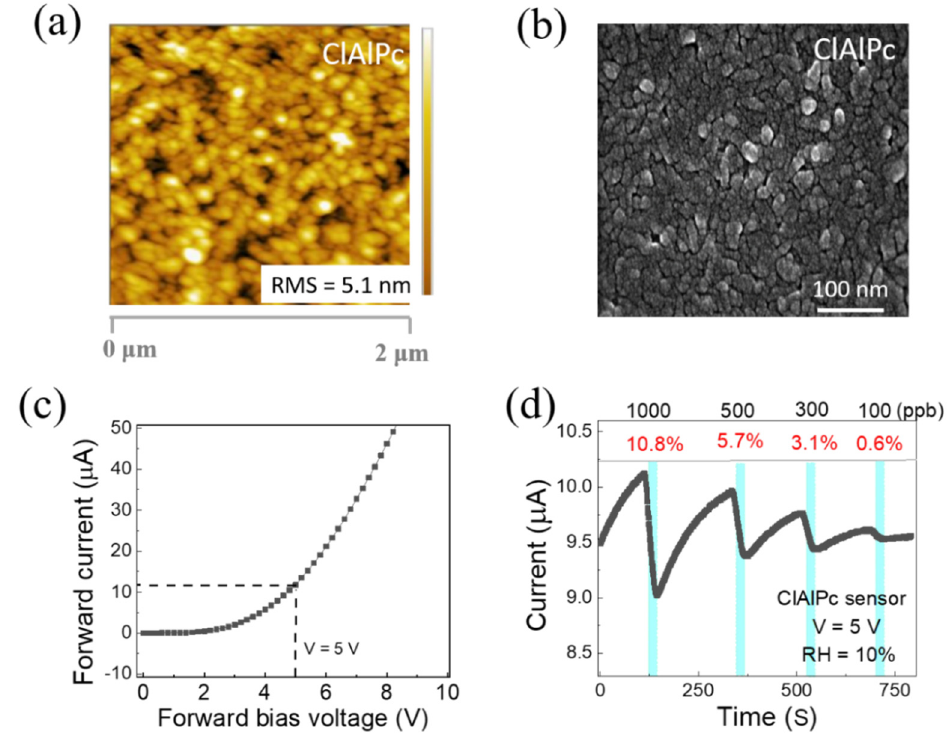
Figure 2. ( a ) AFM and ( b ) SEM images of ClAlPc film. ( c ) Current–voltage characteristic of ClAlPc sensor. ( d ) Representative real-time current of ClAlPc device exposed to ammonia concentrations of 1000, 500, 300, and 100 ppb, sequentially.